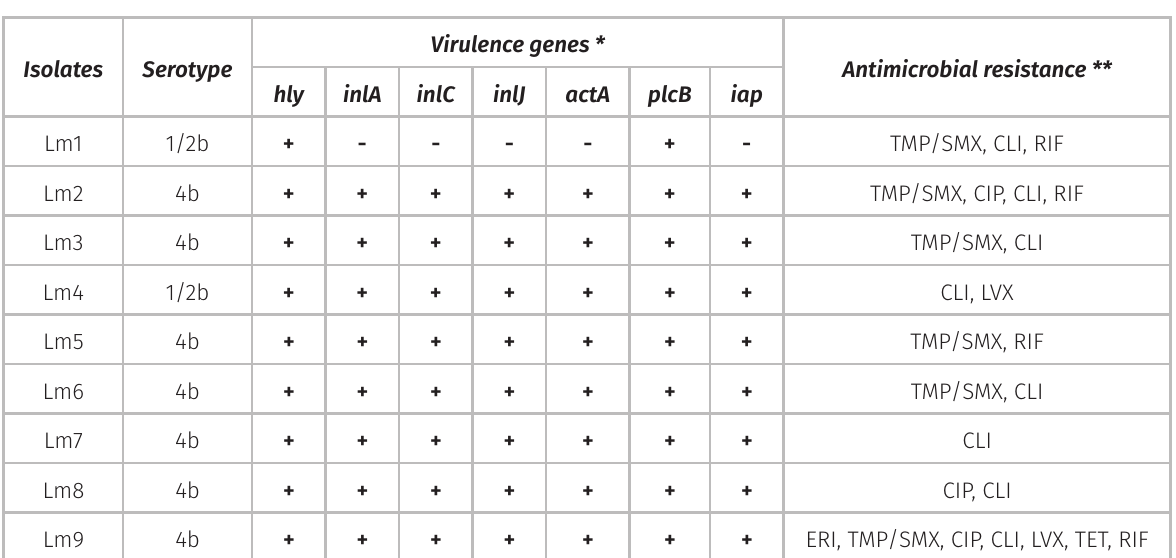
Table II. Profile of virulence and antimicrobial susceptibility of Listeria monocytogenes isolates recovered from serrano artisanal